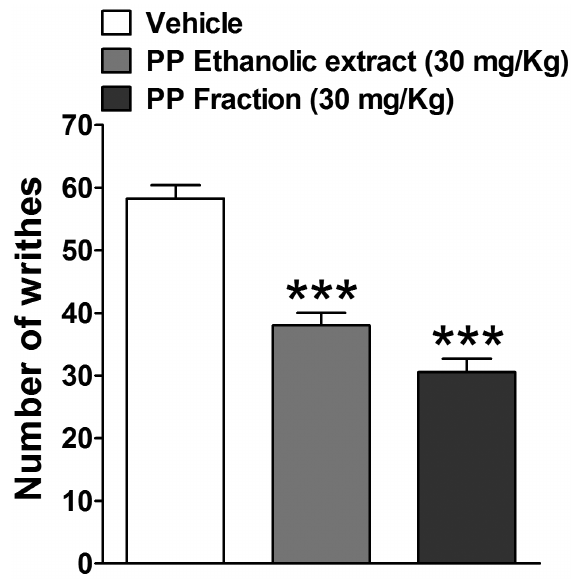
Figure 1 - Effect of EE (30 mg/kg) and PPAC fraction (30 mg/ kg) on abdominal constriction induced by 0.6% acetic acid (0.1 ml/10 g ; i.p. ) in mice after oral administration. Each column represents the mean ± SEM. of 8–11 animals. ***p<0.001 in a one-way ANOVA Bonferroni